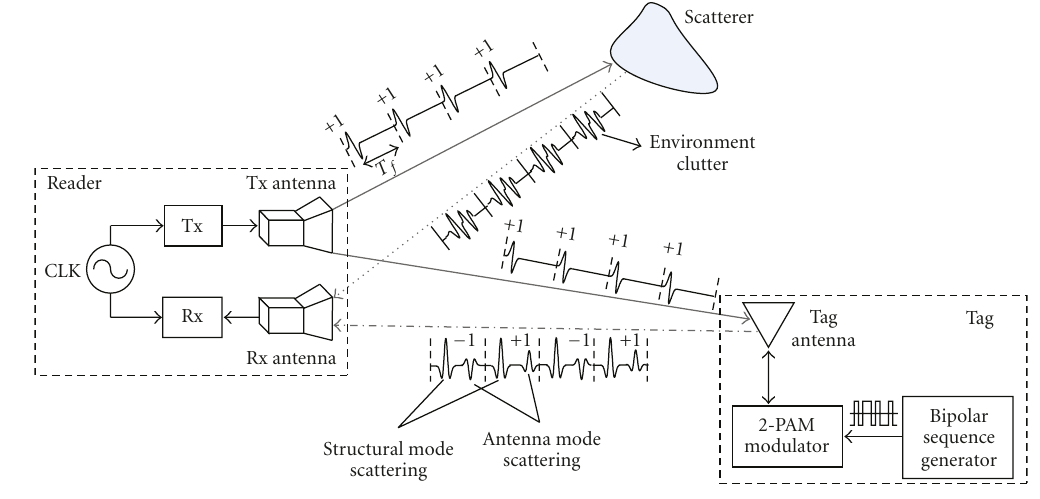
Figure 1: System block